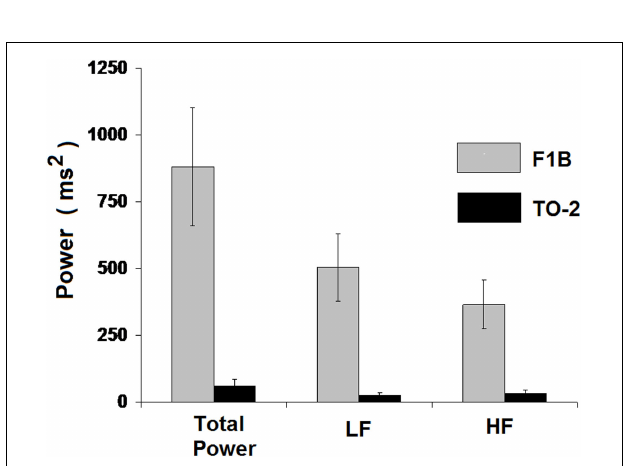
FIGURE 2 | RR tachograms, or analysis of variations in the instantaneous heart rate time series using the beat-to-beat RR intervals, to reflect heart rate variability. Beat-to-beat variability in the RR interval durations was very low in cardiomyopathicTO-2 hamsters, reflecting altered autonomic heart rate modulation in comparison to F1B control hamsters.